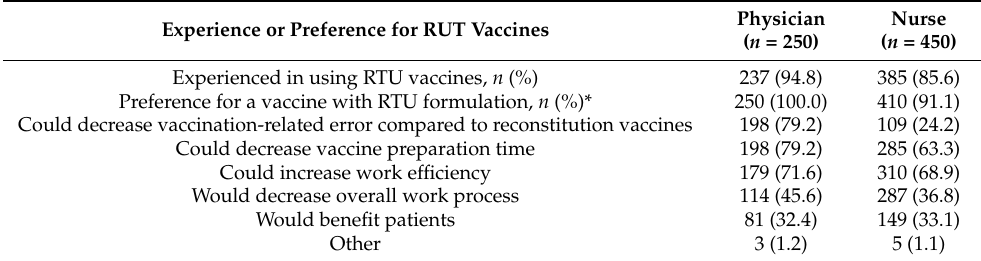
Table 4. Experience or preference for a vaccine with a ready-to-use (RTU) feature by